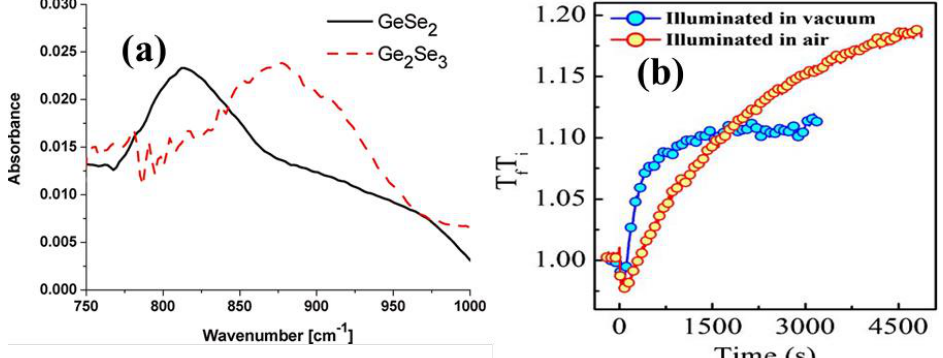
Figure 3. Transmission spectra of ( a ) GeSe 2 and ( b ) Ge 2 Se 3 films when illuminated in the air. Time evolution of transmission at fixed wavelengths for as-prepared ( c ) GeSe 2 and ( d ) Ge 2 Se 3 thin films illuminated in the air. All Figures are reprinted with permission from [22] Copyright 2011, American Chemical Society.